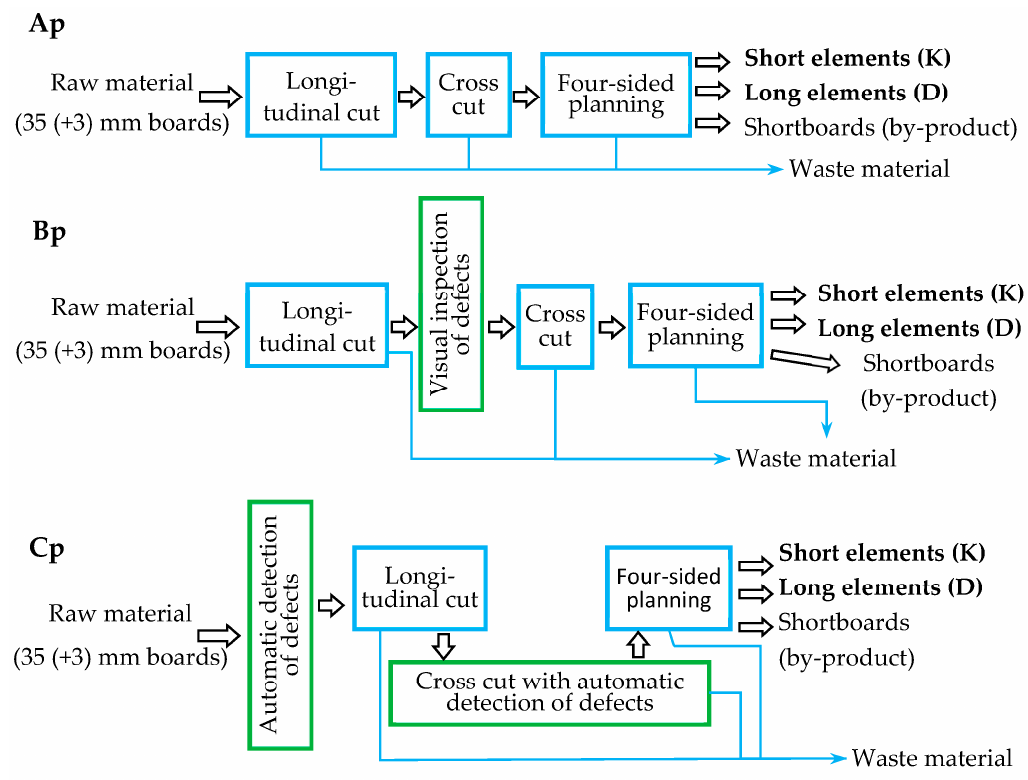
Figure 6. The analyzed variants of the second stage of wood processing (producing semi-finished furniture elements).